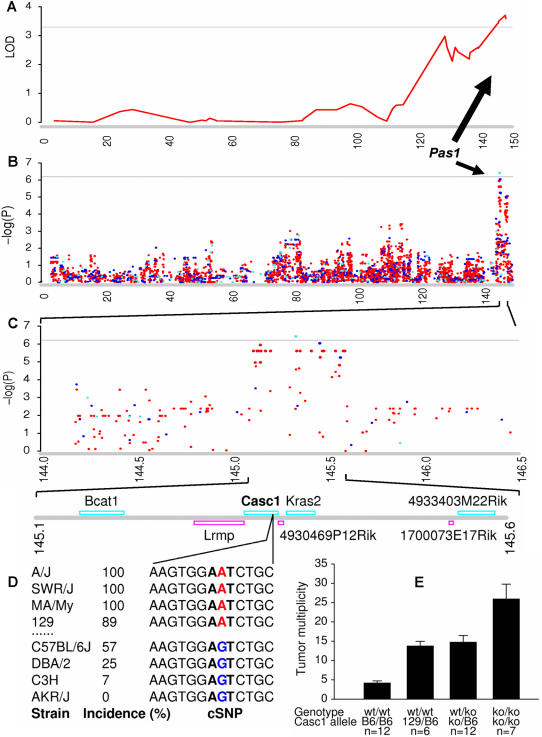
Integration of genomics and phenomics approaches in mapping complex traits in mice.(A) Pulmonary adenoma susceptibility locus 1 (Pas1) was previously mapped to the distal region of chromosome 6 by linkage analysis in A×B and B×A recombinant inbred mice. (B) In silico LD mapping Pas1 using existing mouse SNP and tumor incidence data. (C) Enhanced view of LD mapping between 144.0–146.5 Mb. (D) Physical map of the complex multigenic Pas1 locus. The Casc1 gene carries a functional polymorphism at codon 60 (N60S) between lung tumor susceptible strains (e.g. A/J, SWR/J, MA/MyJ and 129/J) and resistant strains (e.g. C57BL/6J, DBA/2J, C3H/HeJ and AKR/J). (E) Lung tumorigenesis of Casc1 knockout mice. Treatment of Casc1ko/ko mice with urethane produced more than six times as many tumors per mouse than did treatment of Casc1wt-B6/wt-B6 mice. The horizontal coordinates were plotted using physical distance (Mb). In panel A, the horizontal line indicates lod = 3.3, and tumor multiplicity data were used in the linkage analysis. In panel B and C, the horizontal lines indicate –log(P) = 6.2, and urethane-induced lung adenoma incidence data were used in the analysis [4].